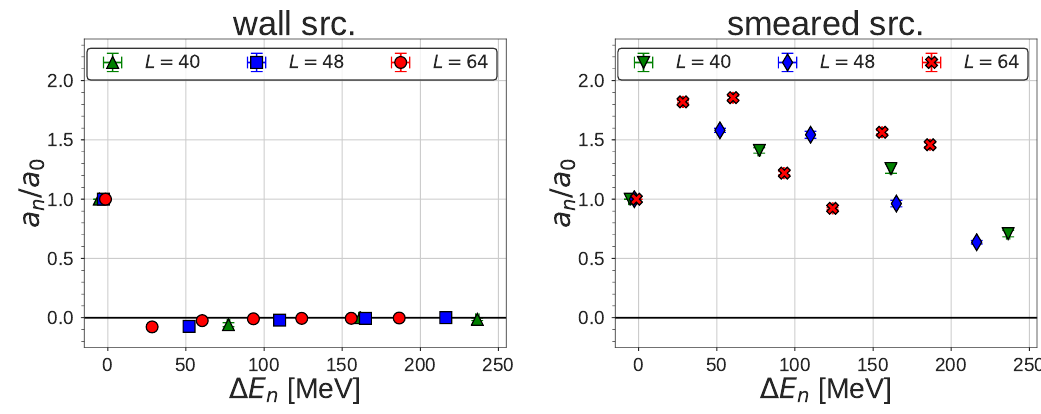
Figure 7 . The ratio of the overlap coe(cid:14)cients a n =a 0 in the R -correlator obtained at t=a = 13 for the wall source (left) and the smeared source (right) on three volumes.